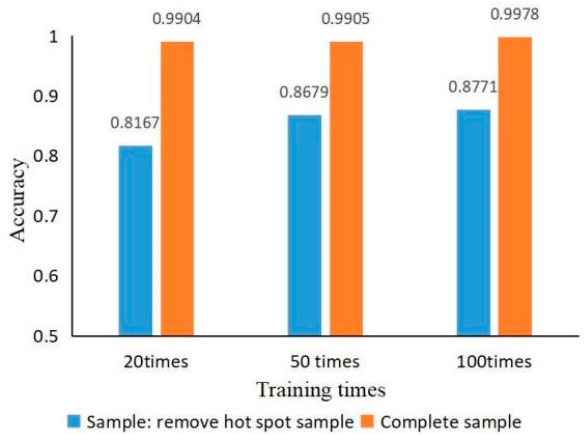
Figure 11. Relationship between source domain samples on the effect of transfer learning.